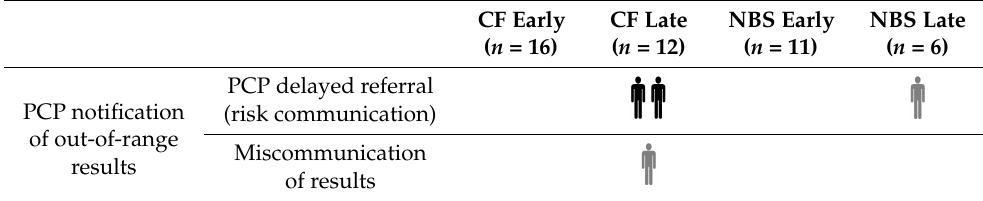
Table 2. Key themes identified listed by analysis groups regarding PCP notification of results to families with an out-of-range CF newborn screen; themes identified by at least 30% of the group are represented by one figure; themes identified by at least 60% of the group are represented by two